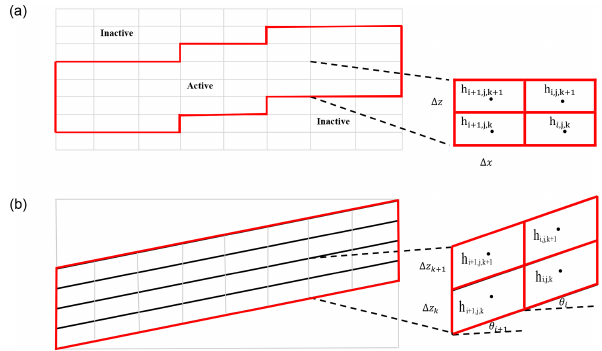
Figure 2. Representation of orthogonal (a) and terrain-following (b) grid formulations and schematics of the associated finite- difference dependences (right). The i , j , and k are the x , y , and z cell